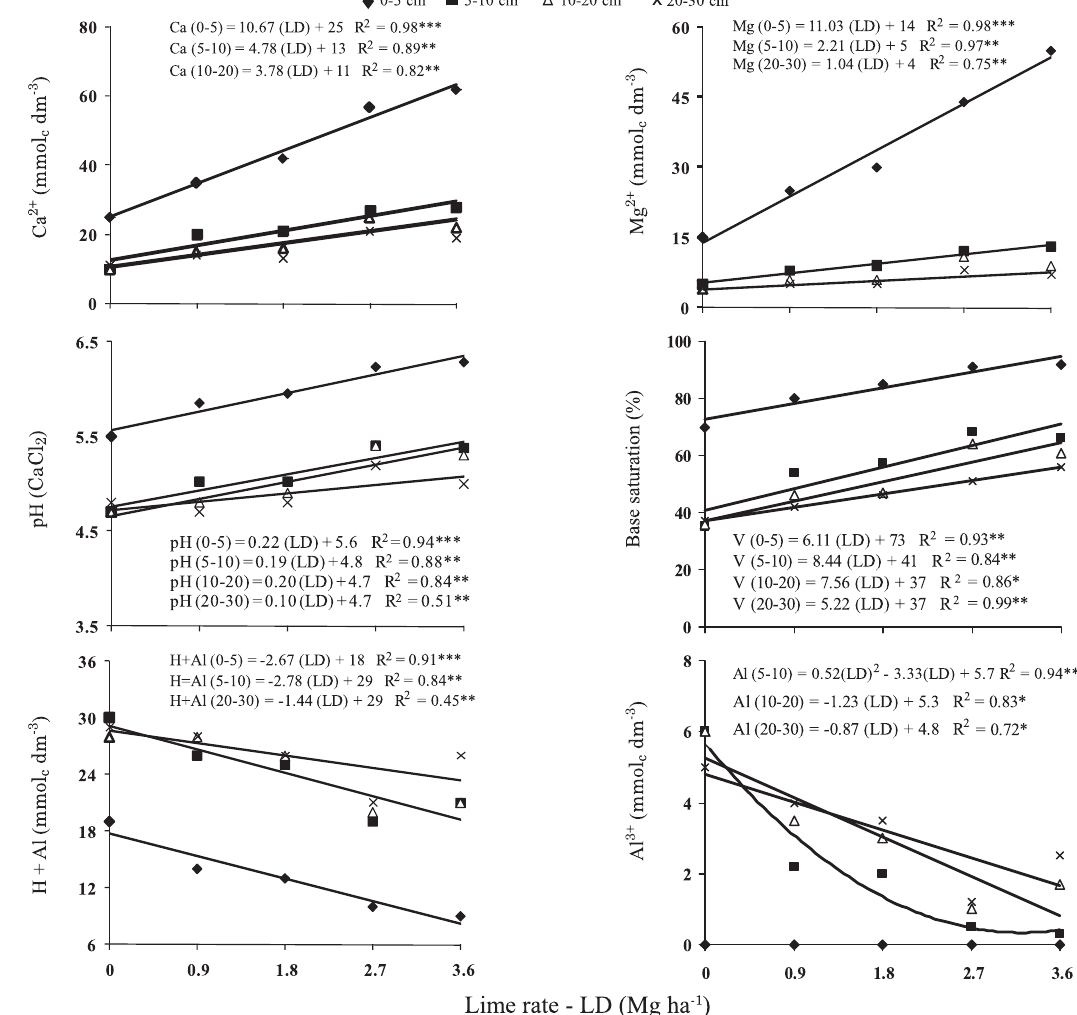
figure 2. exchangeable ca 2+ , mg 2+ , al 3+ and potential acidity (h + al) contents and ph and base saturation values with lime rates, two years after liming. *: (significantly p < 0.10); ** (significantly p < 0.05); ***: (significantly p <